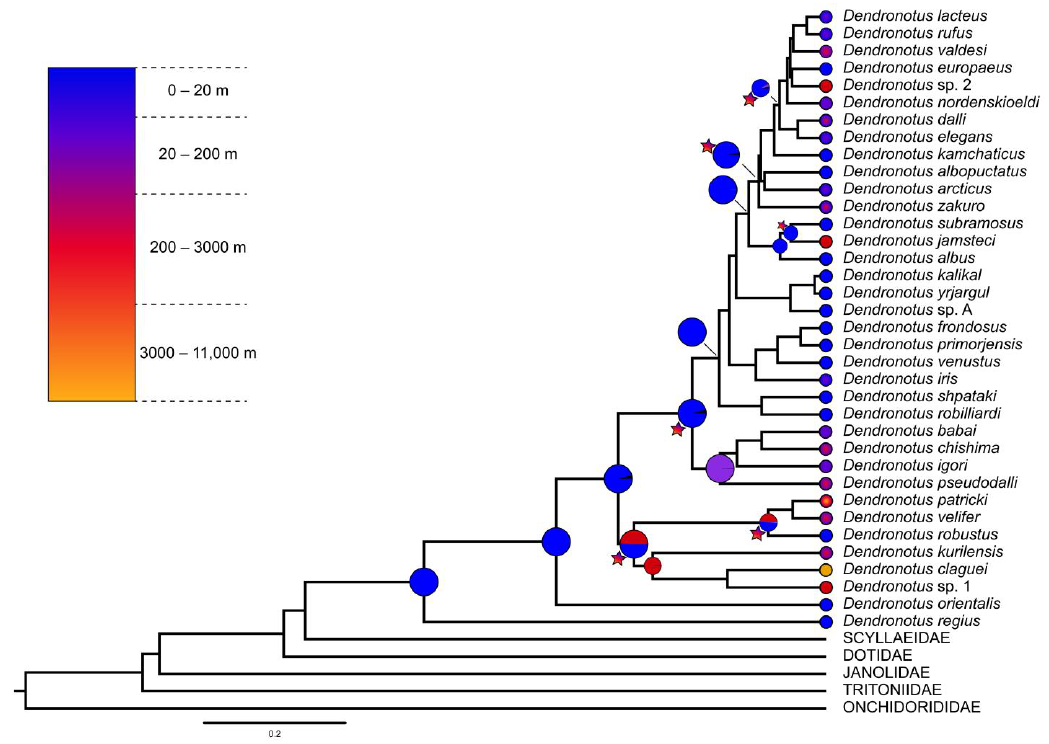
Figure 11. Ancestral area reconstruction estimated from the DEC + J algorithm. Colored circles rep- resent the most likely ancestral bathymetric range of the selected nodes, sectors indicate total range probabilities. Transitions to the deep-sea environments (dispersal events from DEC + J analysis) of the selected nodes are indicated with a star.